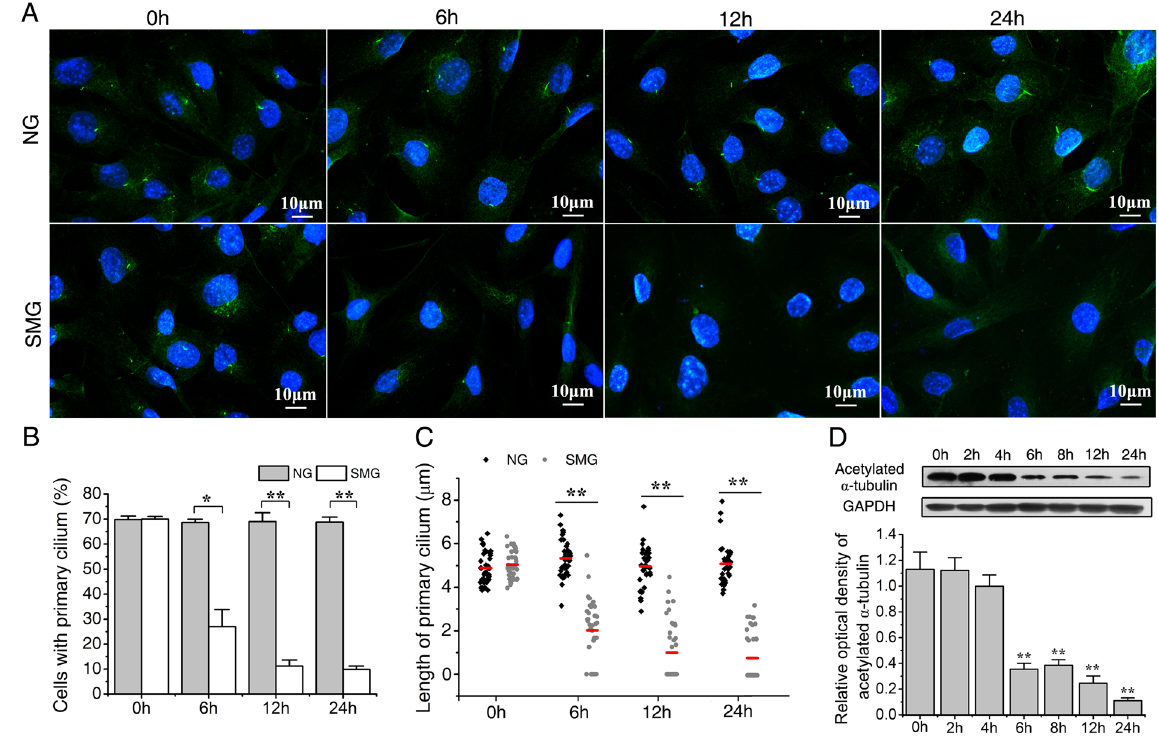
Figure 2. Simulated microgravity significantly abrogates the primary cilia of rat calvarial osteoblasts (ROBs). ( A ) The immunofluorescence image of ROBs with or without random positioning machine (RPM) microgravity treatment. Primary cilia were stained by acetylated α -tubulin (green), and the nuclei were stained with DAPI (blue). ( B ) The percentage of ciliolated cells with or without RPM treatment. ( C ) Means (red bars) and individual measurements of cilium lengths with or without RPM treatment. ( D ) The protein expression levels of acetylated α -tubulin in ROBs with or without RPM treatment. NG: normal ground, SMG: simulated microgravity. Full-length Western blots are presented in Supplementary Figure 1. Each experiment was conducted at least three times independently. * P < 0.05 or ** P < 0.01 vs NG group or 0 h